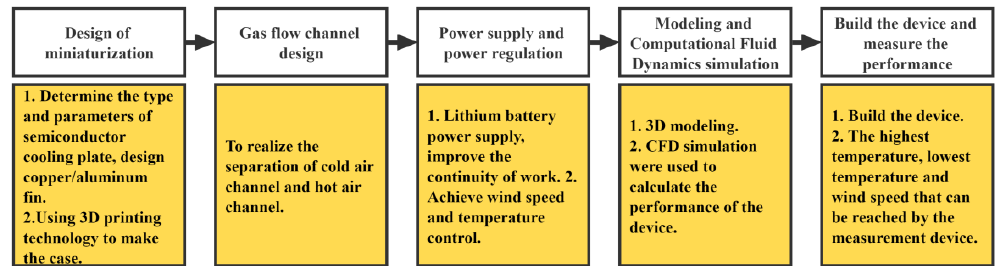
Figure 7. The overall design of the device.